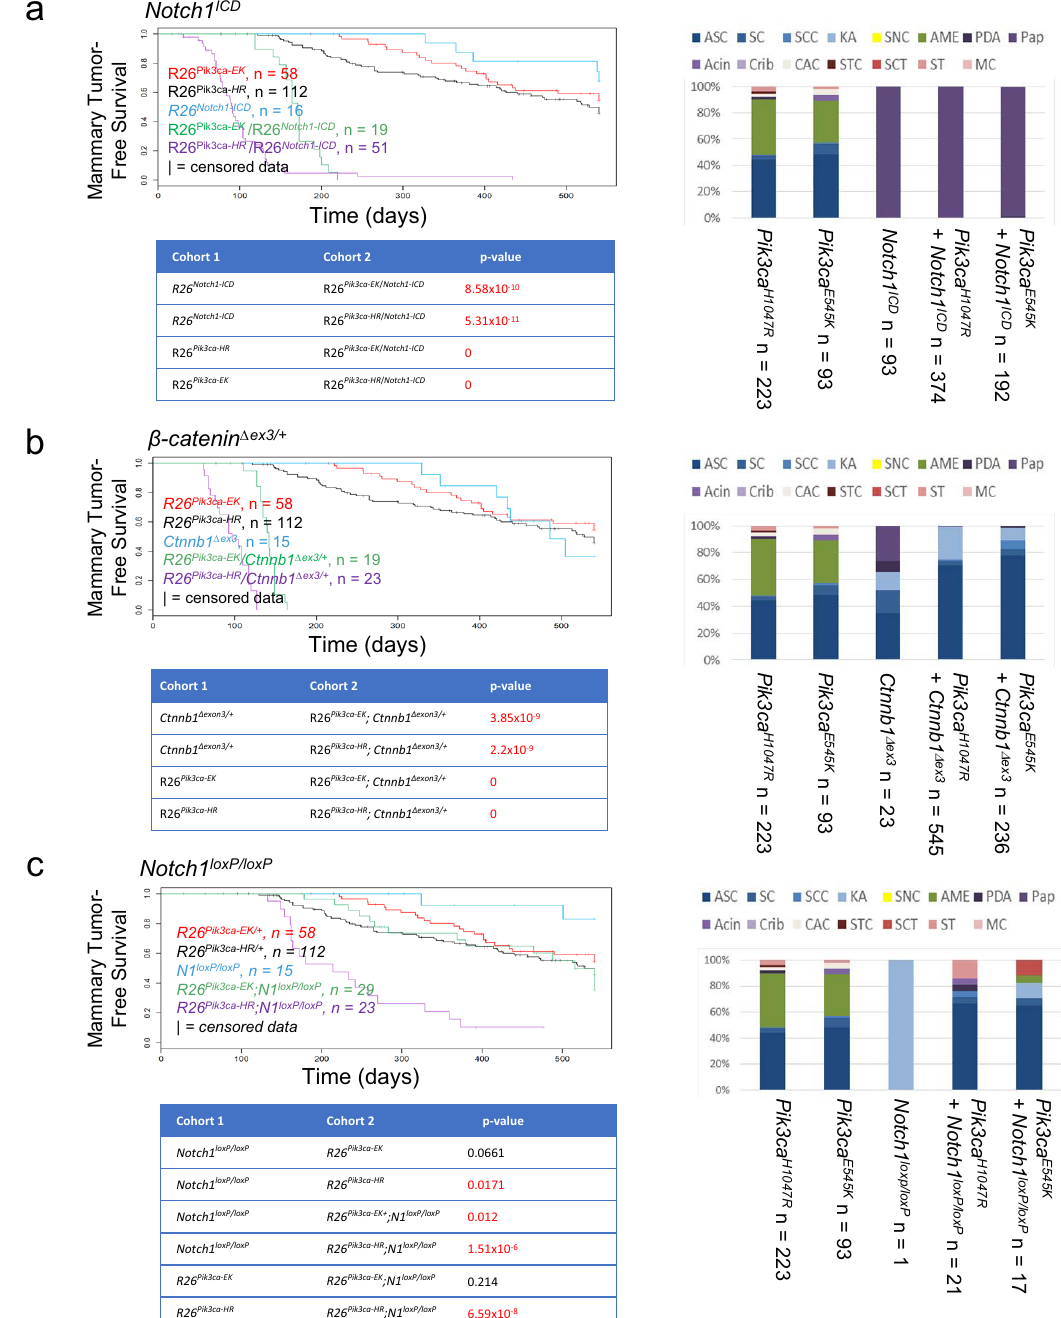
Fig. 6 Mutant Pik3ca alleles cooperate with Notch and Wnt pathway alterations to promote histotype-speci fi c mammary tumor formation in mice. Kaplan – Meier survival analysis (left) and distribution of histotypes for mammary lesions (right) from a mouse cohorts expressing Pik3ca E545K or H1047R and activated Notch1 ICD , alone or in combination. b Mouse cohorts expressing Pik3ca E545K or H1047R and activated β -Catenin, and c Pik3ca E545K or H1047R ;Notch1 loxP/loxP double mutant mice and controls. Mice in each cohort are also positive for MMTV-Cre NLST . R26 Pik3ca-EK = Rosa26-LSL- Pik3ca E545K mice, R26 Pik3ca-HR = Rosa26-LSL- Pik3ca H1047R mice, R26 Notch1-ICD = R26-LSL- Notch1 ICD mice, β -catenin Δ exon3/ + = Ctnnb1 δ ex3/ + mice and N1 loxP/ loxP = Notch1 loxP/loxP mice. For all Kaplan – Meier survival curves, statistical signi fi cance was calculated using the log-rank (Mantel – Cox) test.